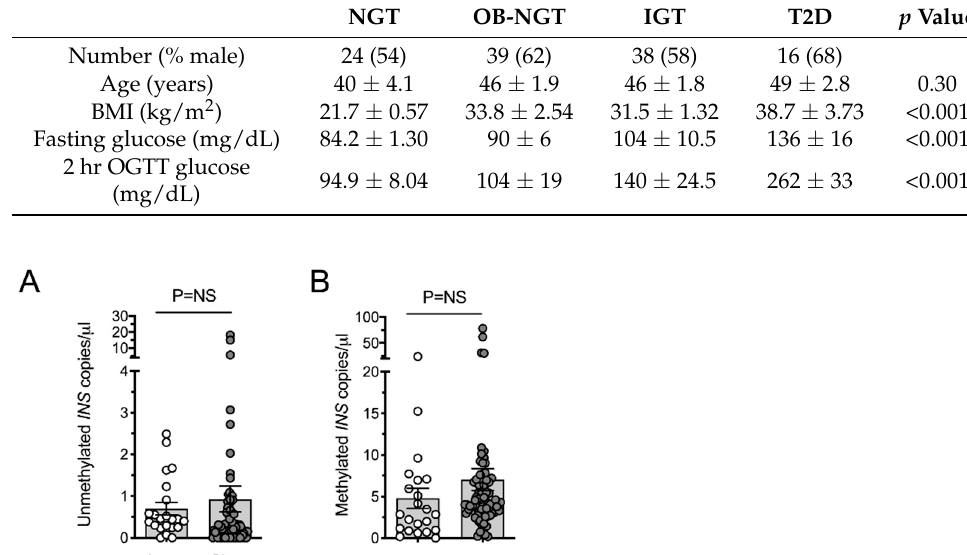
Table 2. Subject characteristics. Subjects are divided into categories based on oral glucose tolerance test (OGTT) 2hr-glucose concentrations: normal glucose tolerance (NGT, <140 mg/dL), obese-normal glucose tolerance (OB-NGT, <140 mg/dL), impaired glucose tolerance (IGT; 140–199 mg/dL), and T2D ( ≥ 200 mg/dL). Exclusion criteria: Metformin use four weeks previous, thiazolidinedione use six months previous, T1D, other diabetes, pregnancy, weight fluctuation six months previous, current or past tobacco use, acute or chronic illness, pulmonary disease, or use of antidepressants. Participants were provided written informed consent for screening and study participation. The study was approved by the Indiana University School of Medicine Institutional Review Board. OGTT: Oral glucose tolerance test.